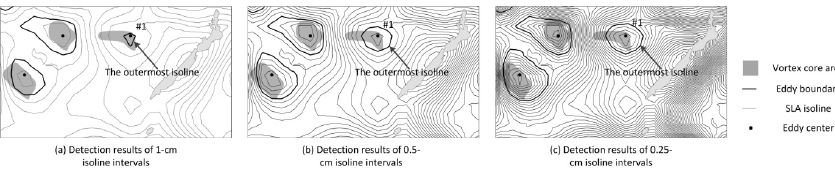
Fig. 3. Detection results of different contour intervals. The eddy boundary is determined by the HD algorithm that has combined the OW criterion and the SSH-based criterion.